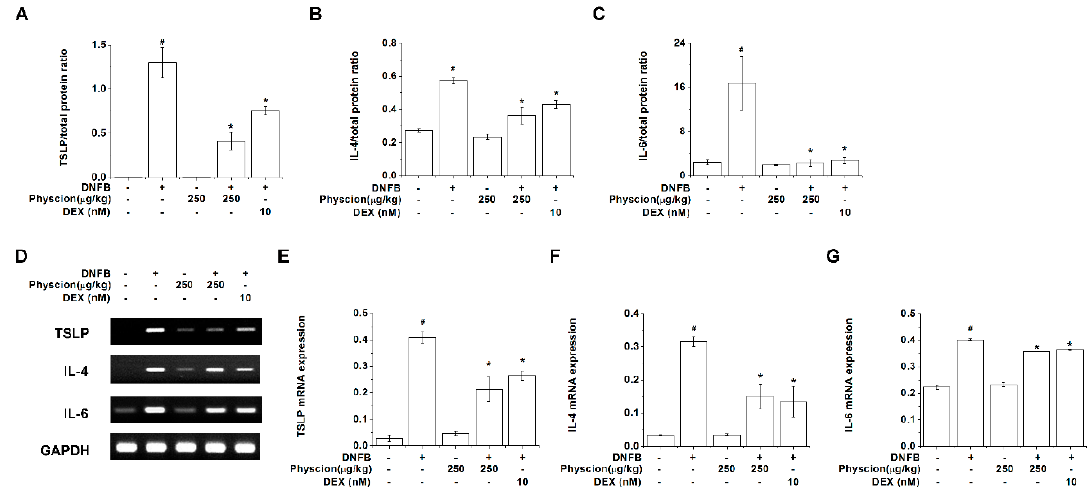
Figure 7. Physcion reduces TSLP, IL-4, and IL-6 expression levels in lesional skin. The protein expression levels of ( A ) TSLP, ( B ) IL-4, and ( C ) IL-6 in the lesional skin homogenate were detected by ELISA. ( D ) Representative reverse-transcription PCR gels are shown in the lesional skin tissues. The mRNA expression levels of ( E ) TSLP, ( F ) IL-4, and ( G ) IL-6 were normalized to the levels of GAPDH and expressed as fold induction relative to a vehicle group. Each mRNA level was quantified using the Image J software. # p < 0.05 vs. a vehicle group. * p < 0.05 vs. a DNFB control group.